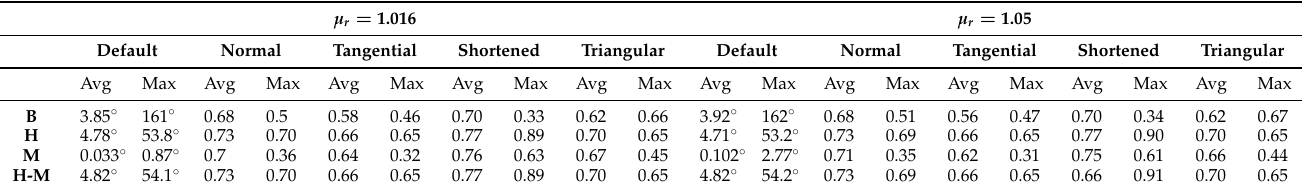
Table 8. No-load angular dependency for B , M and H for different relative permeability values for the linear machine. For the design alterations, the inclination angles are given as a fraction of the respective inclination angle for the default case. The pole shoe alterations are illustrated in Figure 6.